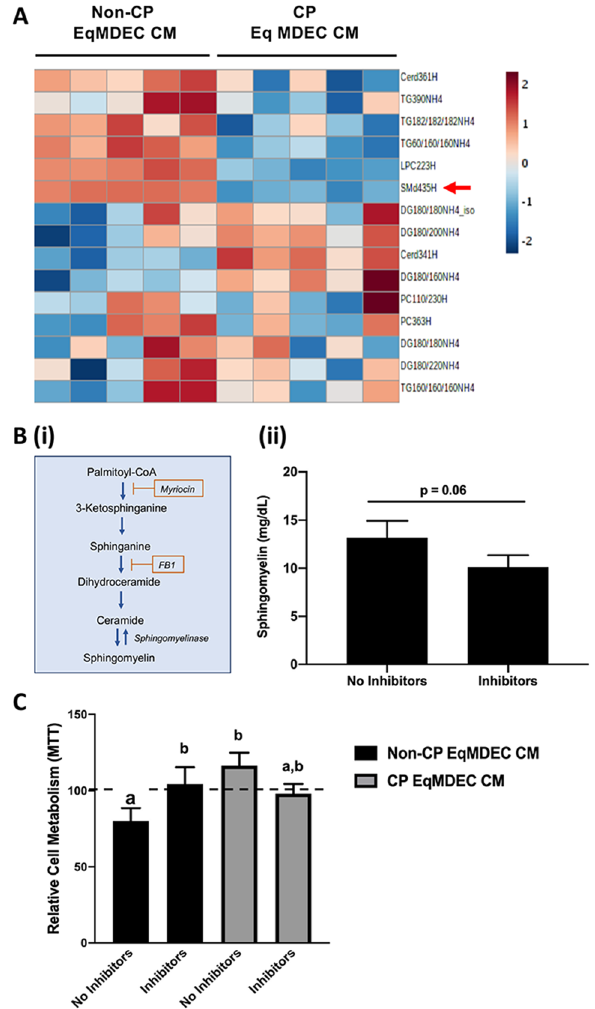
Figure 5. Sphingomyelins were found to mediate reduced cell viability of triple-negative human breast cancer (TNBC) cells. ( A ) Heat map showing lipid profiles of non-CP and CP EqMDEC CM. Red arrow indicates sphingomyelins. n = 5/group. ( B ) Simplified schematic overview of the sphingomyelin pathway, indicating where myriocin and fumosin B1 act to block sphingomyelin synthesis (i) and sphingomyelin concentration in CM collected from non-CP EqMDEC treated with or without sphingomyelin pathway inhibitors, as determined by a sphingomyelin assay kit (ii). ( C ) MTT assays of MDA-MB-231 cells cultured for 48 h with CM collected from non-CP and CP EqMDEC that were treated with or without sphingomyelin inhibitors. Asterisks depict significant differences: **p < 0.01. ns: not significant, n = 3. Data are presented as the mean ± standard